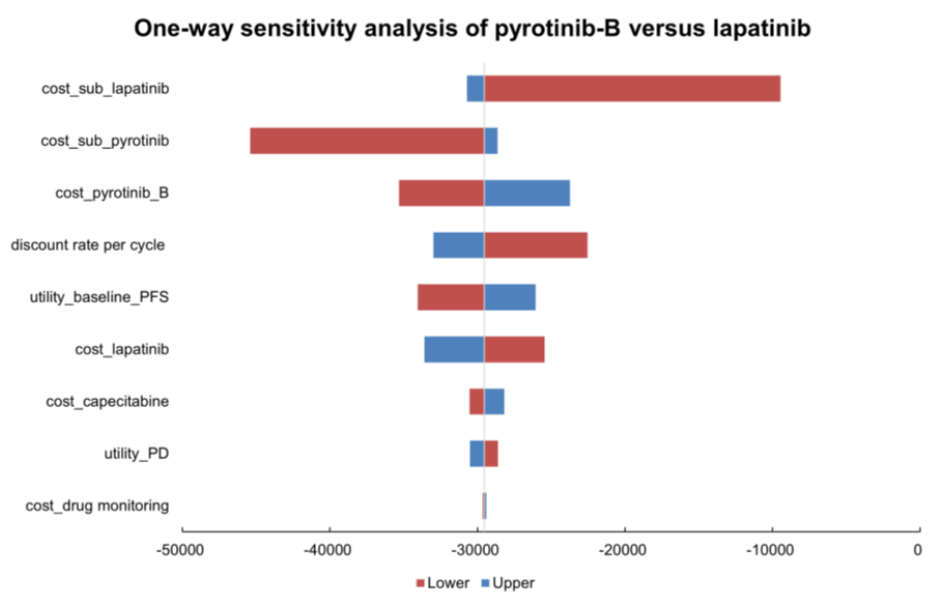
Figure 4. Tornado diagram for one-way sensitivity analysis of pyrotinib-B plus capecitabine versus lapatinib plus capecitabine. Abbreviations: pyrotinib-B, pyrotinib after being enrolled in National Reimbursement Drug List; PFS, progression-free survival; PD, progressive disease; sub, subsequent.